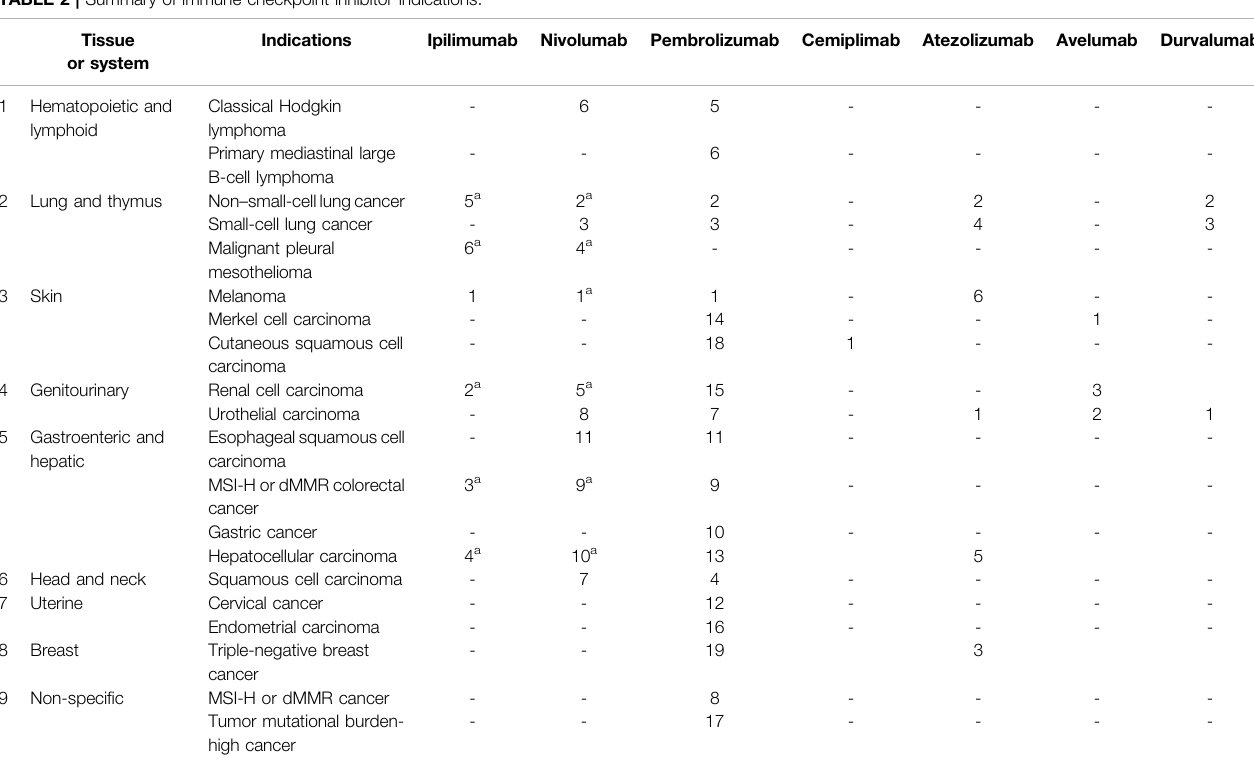
TABLE 2 | Summary of immune checkpoint inhibitor indications. Tissue or